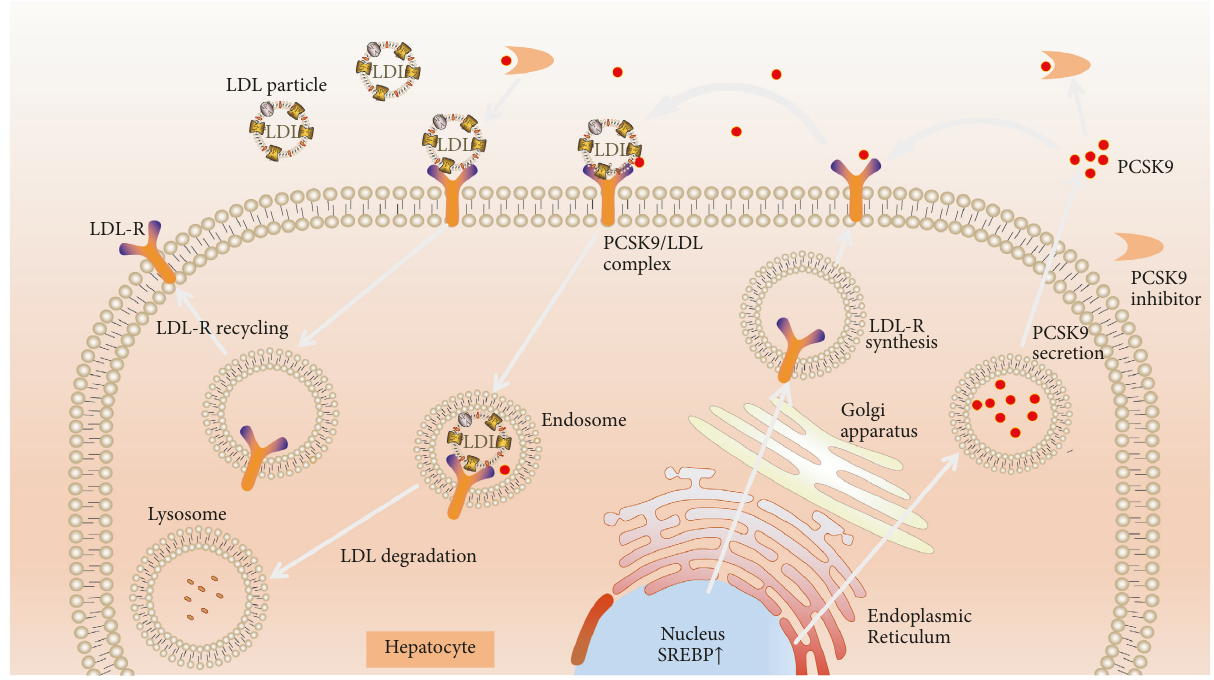
Figure 1: Mechanism of PCSK9 inhibitors: LDLR binds to circulating LDL particles then LDLR/LDL complexes are internalized in endosomes. In the endosome, LDL is carried to lysosome to be degraded when LDLR is recycled to the cell surface. When PCSK9 is present, it binds to LDLR to induce its internalization and degradation in lysosomes. This leads to decreased LDLR expression on the cell surface therefore increases circulating LDL-C